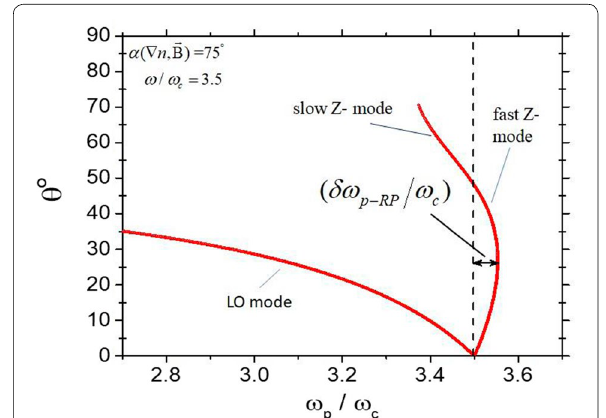
Fig. 7 Variations of the wave normal angle as a function of ω p under the condition satisfying Eq. (4) where to B